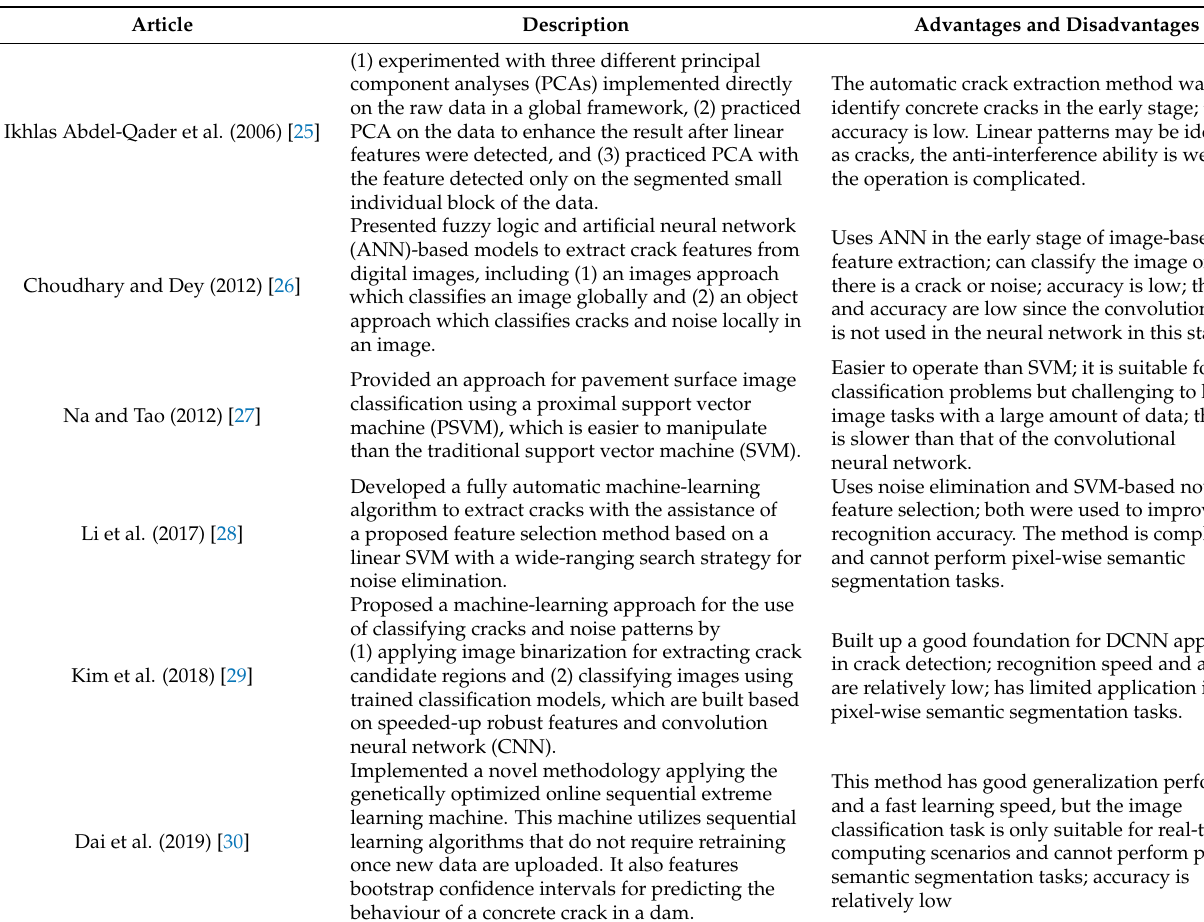
Table 1. Computer vision-based defect detection in